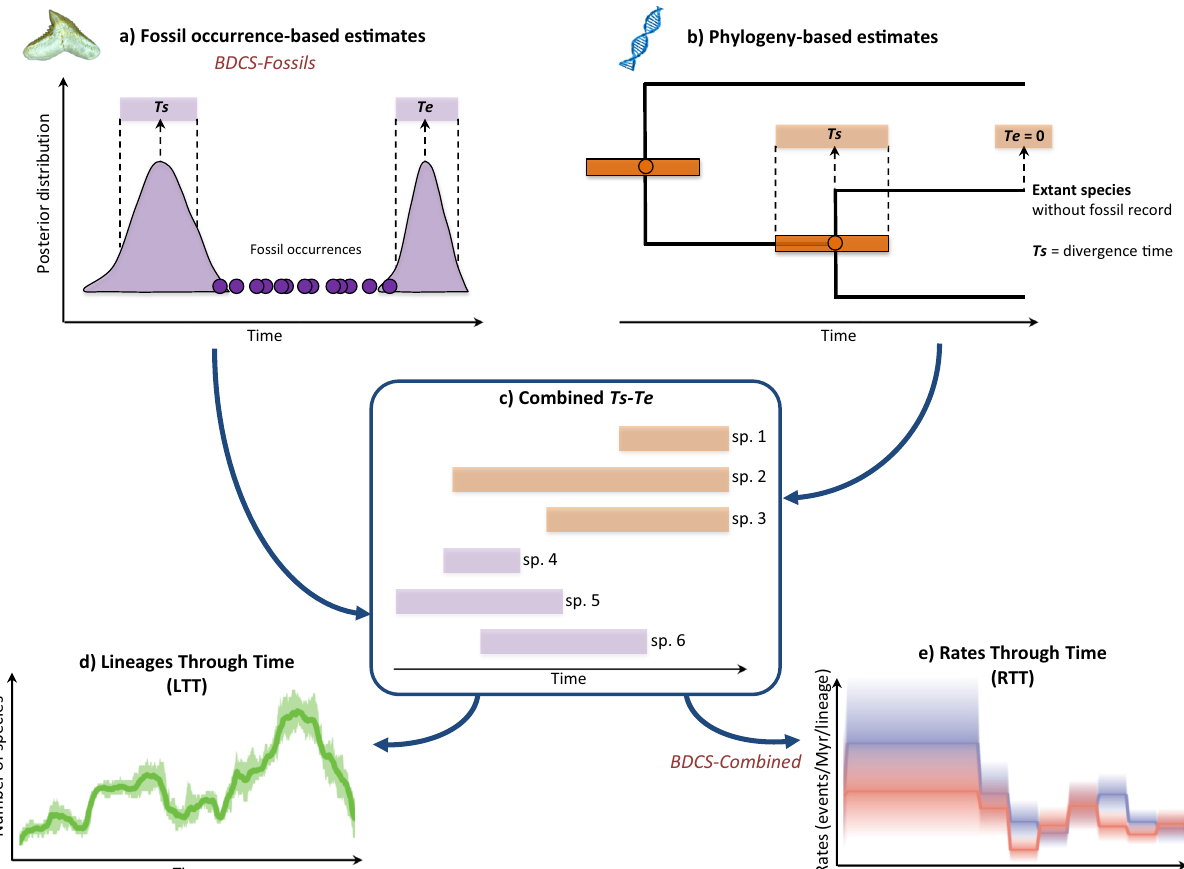
Figure 3. Extraction and combination of inferred times of speciation ( Ts ) and extinction ( Te ). ( a ) Plot showing an example of sampled fossil occurrences (purple circles) with ages obtained from uniform distributions between their minimum and maximum ages (retrieved from the geological strata), and the estimated posterior distributions of Ts and Te (and 95% HPD). ( b ) Phylogeny showing an example of species relationships with branch lengths proportional to time and nodes representing estimated divergence times (and 95% HPD). ( c ) Ts and Te estimates for species represented by fossil occurrences are combined with Ts estimates for extant species without fossil record extracted from the phylogeny ( Te = 0 for extant species). This allows computing the lineages-through-time (LTT) plot ( d ) and the speciation and extinction rates through time (RTT) plot ( e ). Fossil tooth picture of † Galeocerdo eaglesomei (Eocene, Togo) from G. Guinot; DNA symbol from Wikimedia